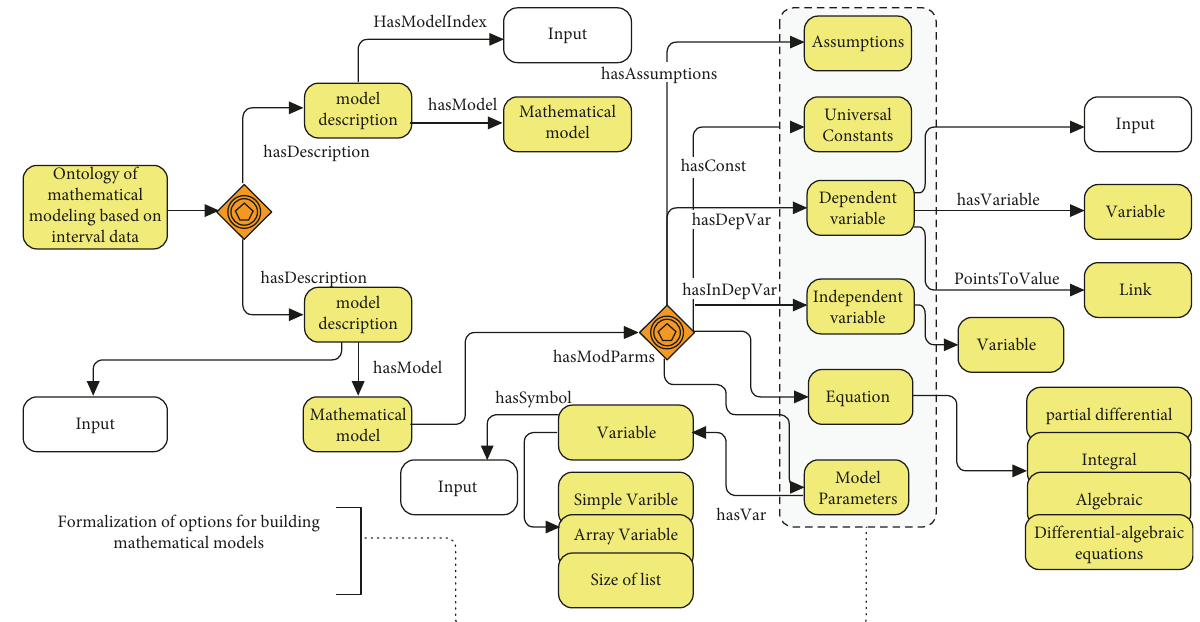
Figure 2: Scheme of description of the ontology of mathematical models on the basis of interval data.